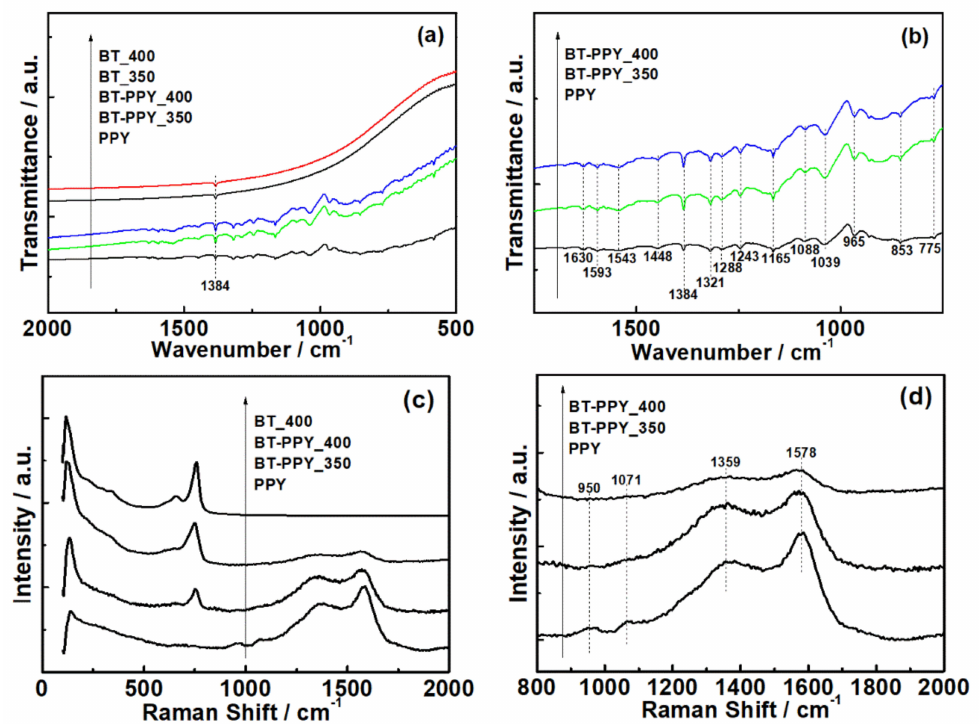
Figure 3. ( a ) FTIR spectra of pristine Bi 2 Te 3 (BT) and Bi 2 Te 3 –polypyrrole (BT-PPY), which were individually sintered at 350 and 400 ◦ C, and polypyrrole (PPY); ( b ) enlarged FTIR spectra of BT-PPY and PPY in the wavenumber range from 750 to 1750 cm − 1 ; ( c ) Raman spectra of BT, BT-PPY, and PPY; ( d ) enlarged Raman spectra of BT-PPY and PPY in the range of Raman shift from 800 to 2000 cm − 1